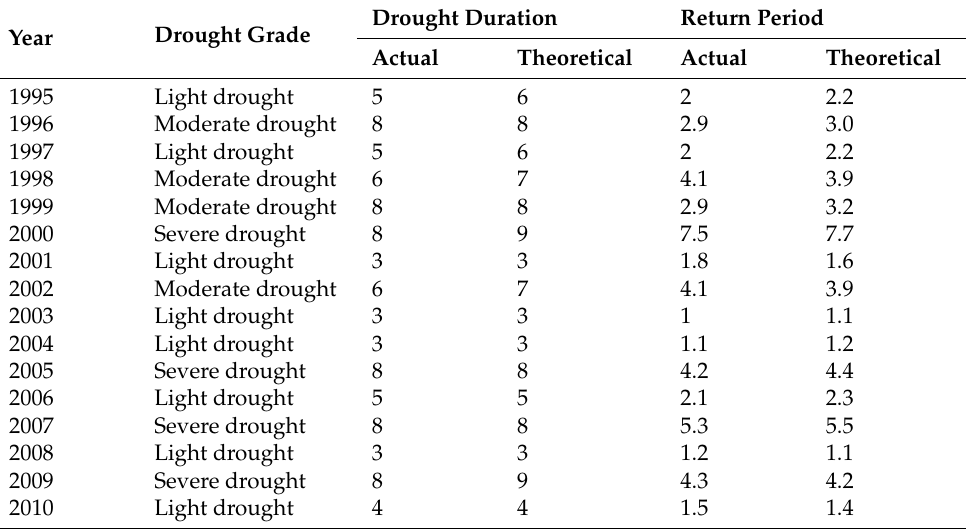
Figure 7. Agricultural production reduction caused by drought in Northern Shaanxi from 1995 to 2010. Table 6. Comparison of theoretical drought events and actual drought events in Northern Shaanxi during